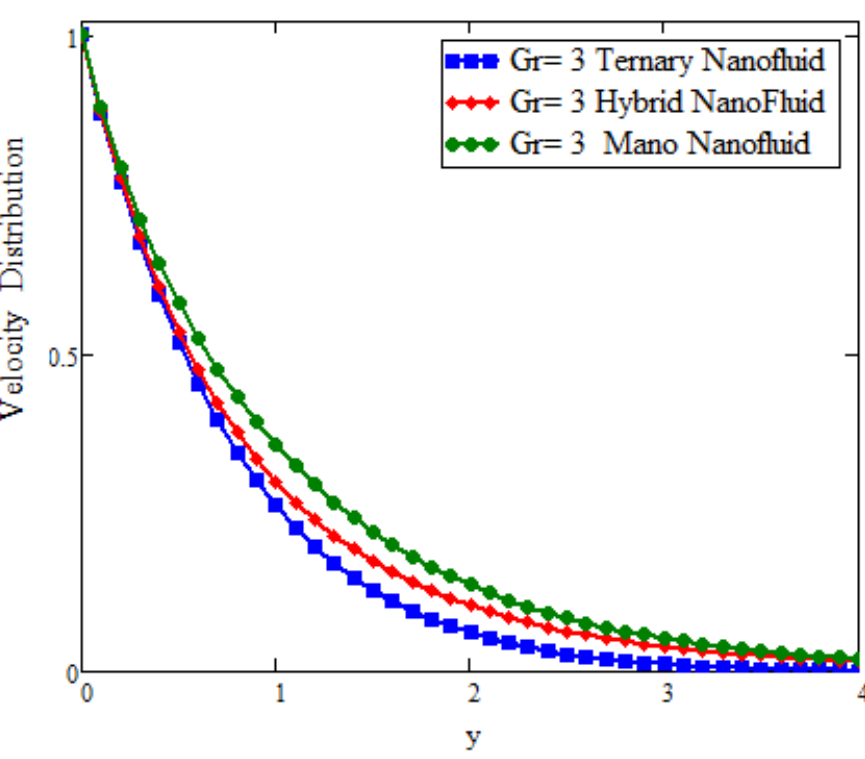
Figure 7. Comparison of velocity assessment with Gr across y as α = 0.5, β = 0.5, γ = 0.5 when t = 1, Sc = 9.2, φ 1 = 0.02, φ 2 = 0.03, φ 3 = 0.04, Pr = 21, and M =